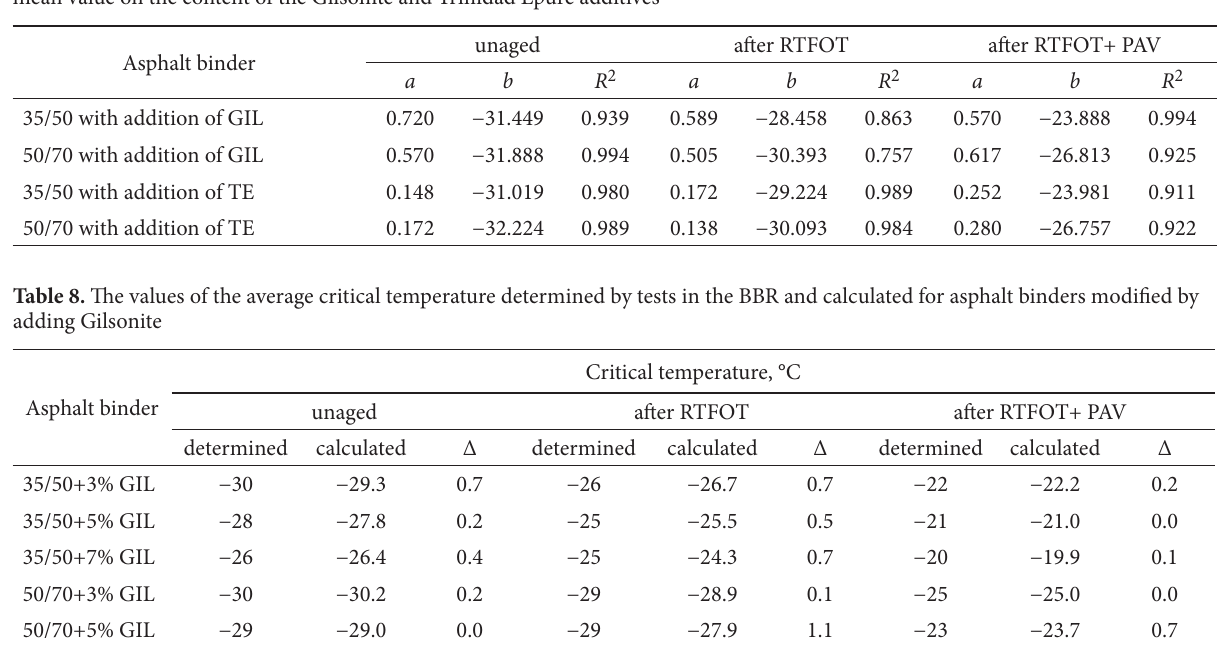
Table 9. The values of the average critical temperature determined by tests in the BBR and calculated for asphalt binders modified by adding Trinidad Epuré